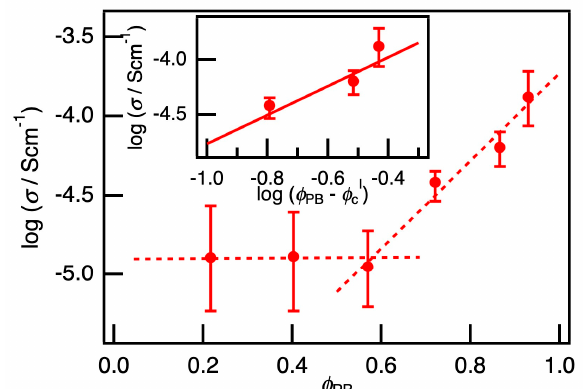
Figure 2. The volume fraction of PB component ϕ PB dependence of the conductivity σ . The crossover point could be observed at the percolation threshold ϕ cI = 0.57. The inserted chart shows log σ v.s. log ( ϕ PB – ϕ cI ). From a slope, the critical exponent t I can be estimated to be 1.3.